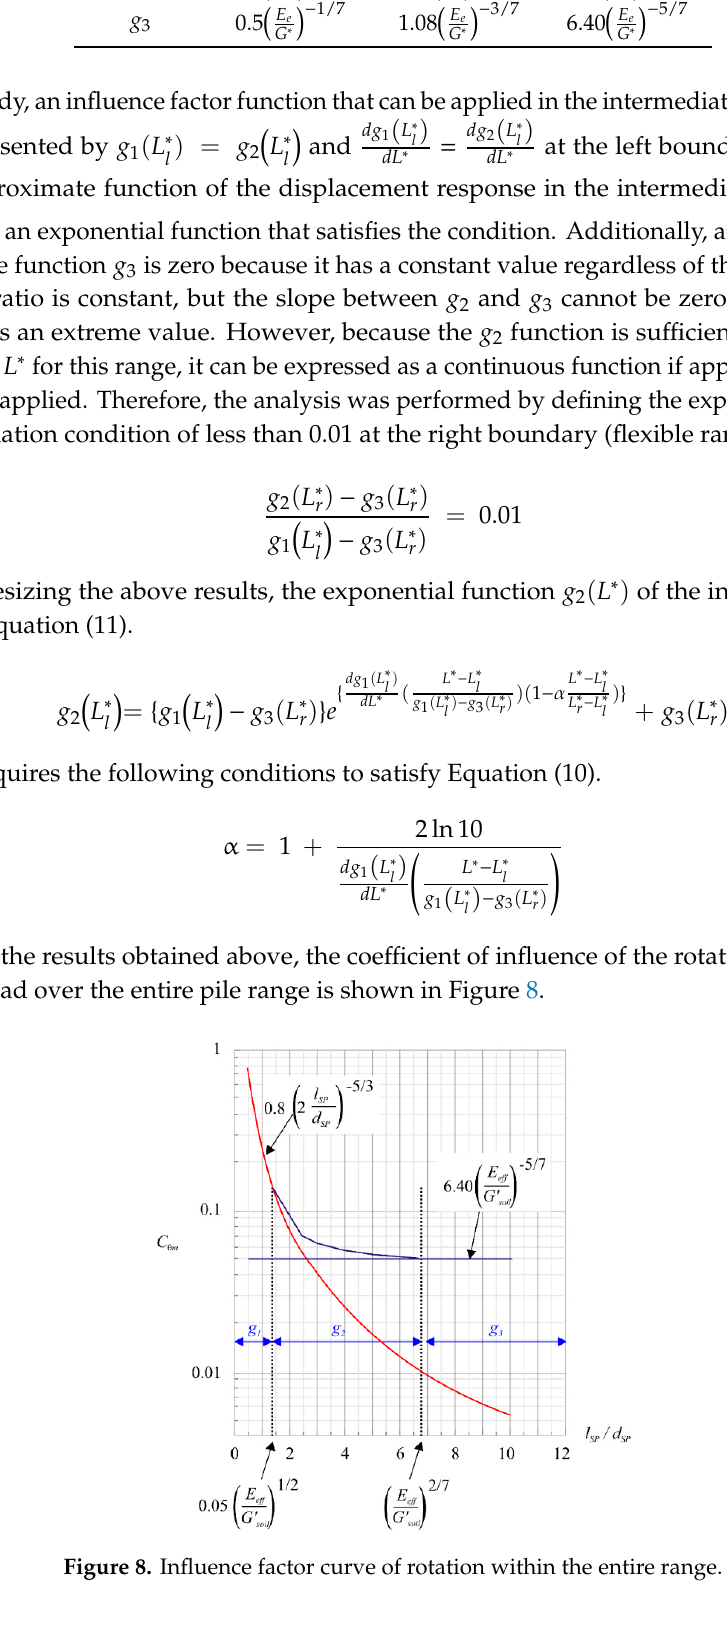
Table 1. Influence factors for a single suction pile.